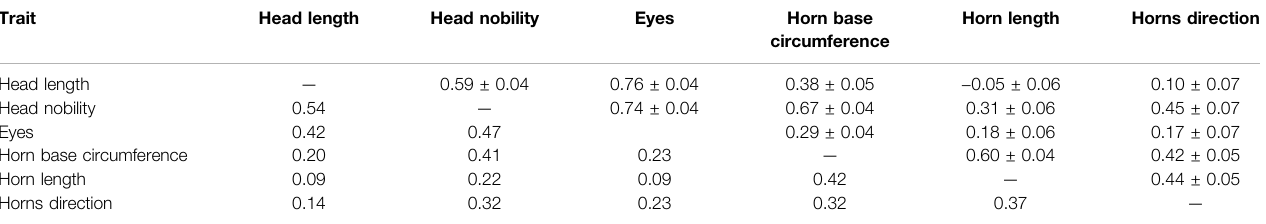
TABLE 4 | Estimated genetic correlations ± standard errors (above diagonal) and phenotypic correlations (bellow diagonal) for scored autochthonous traits from Group 2. Trait